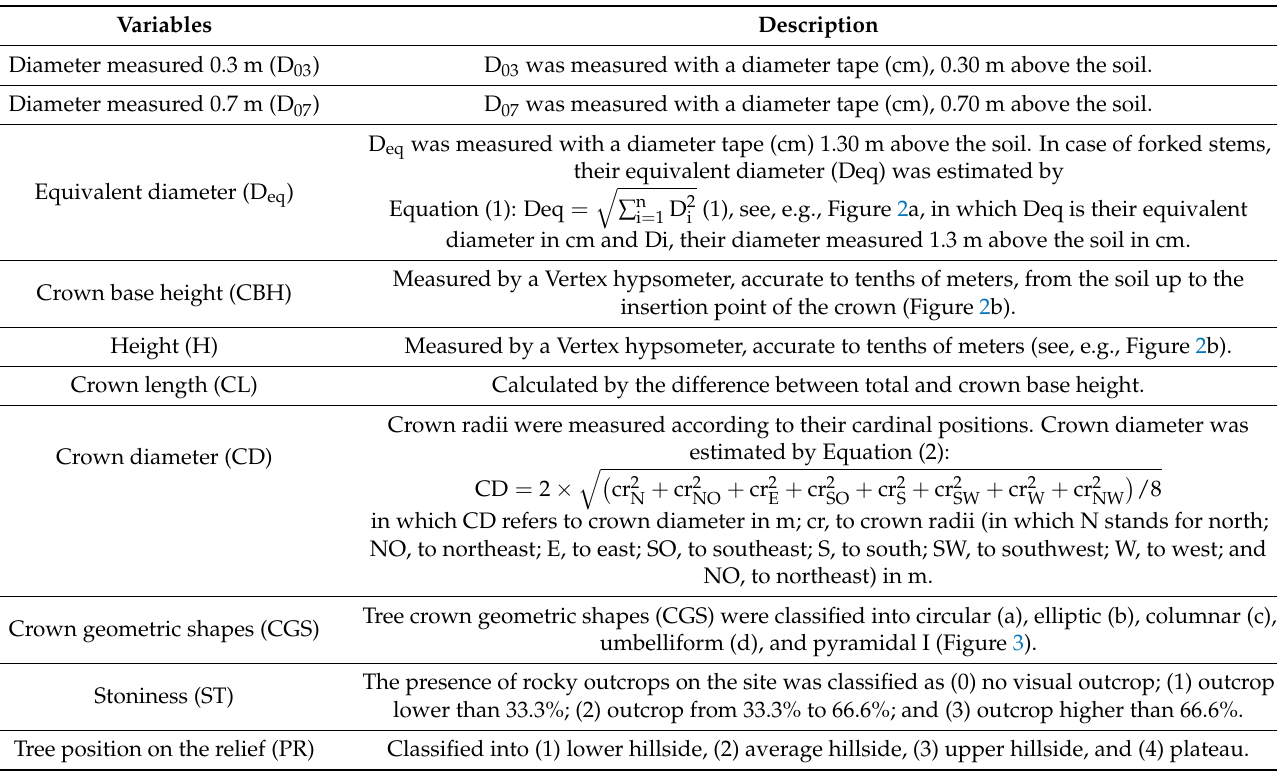
Figure 1. Location of the study area in the Brazilian Cerrado biome ( a ), its southern region ( b ), and the context of the municipality ( c ). Table 1. Description of the attributes measured for each